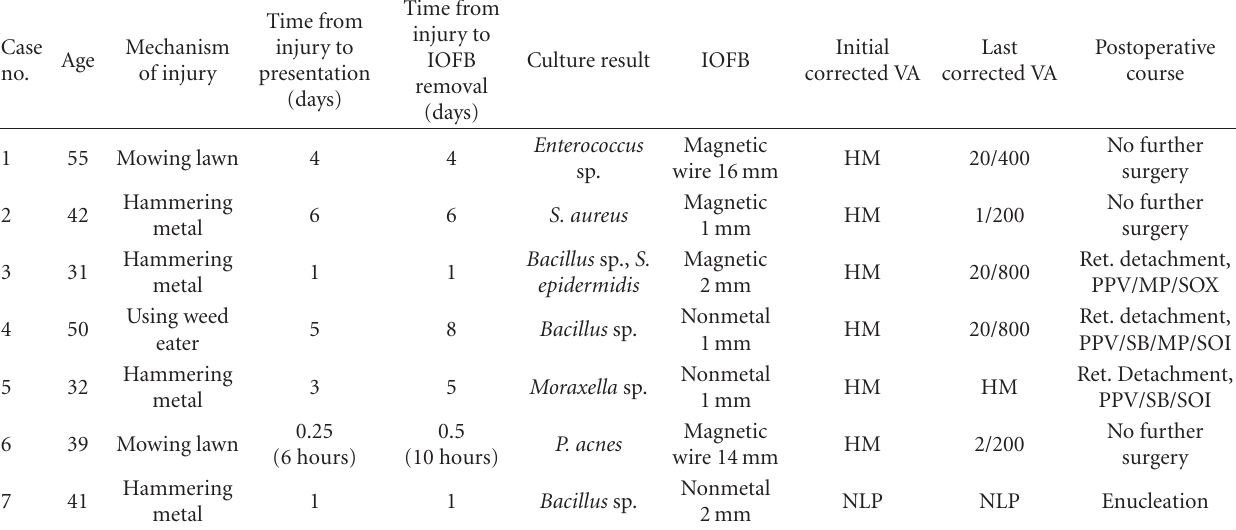
Table 2: Endophthalmitis in eyes with IOFBs: demographics, organisms, and